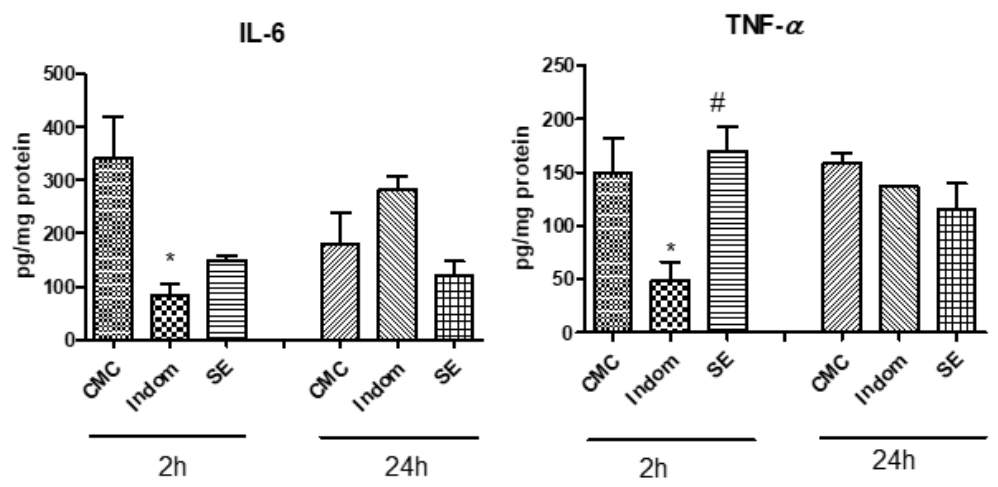
Figure 2. The effect of SE treatment on IL-6 and TNF- α levels in rat paw tissue at 2 h and 24 h after injection of carrageenan. Values are expressed as means ± SD. Statistical analysis was performed using a one-way ANOVA, with Tukey’s multiple comparisons post-test (* p < 0.05 vs. control group; # p < 0.05 vs. Indom group).